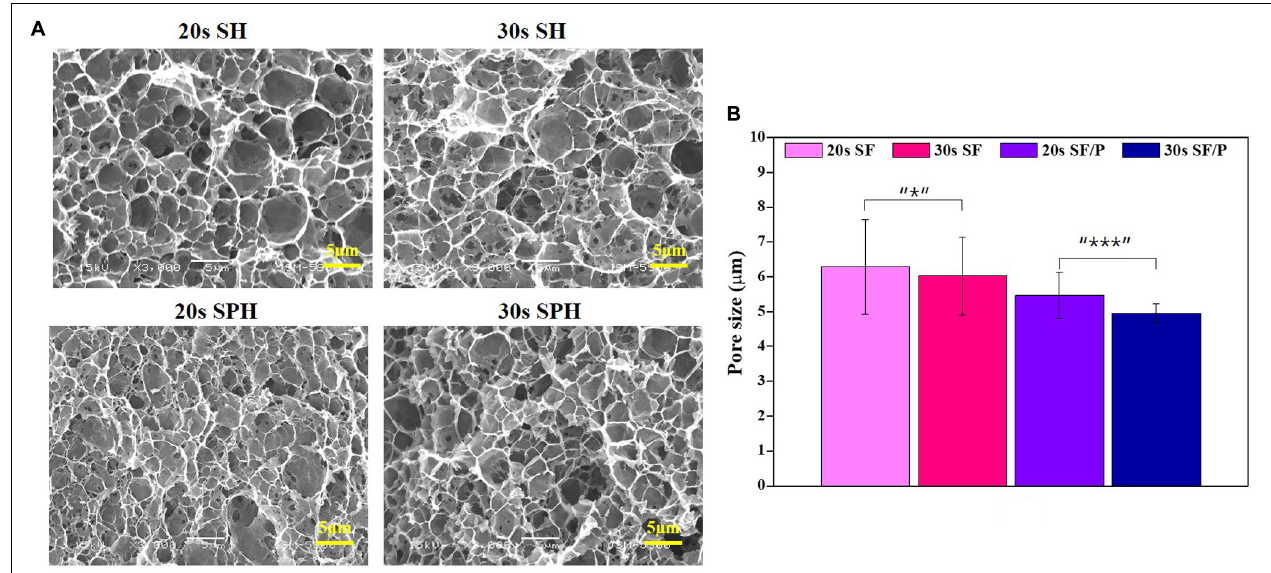
FIGURE 1 | (A) SEM microphotographs to insert gross image of SF, SF/P hydrogels (magnification with 3,000 × , scale bar = 5 µ m). (B) Pore size of freeze dried SF and SF/P hydrogels ( n = 3 in each group; * p < 0.05 and *** p < 0.001).